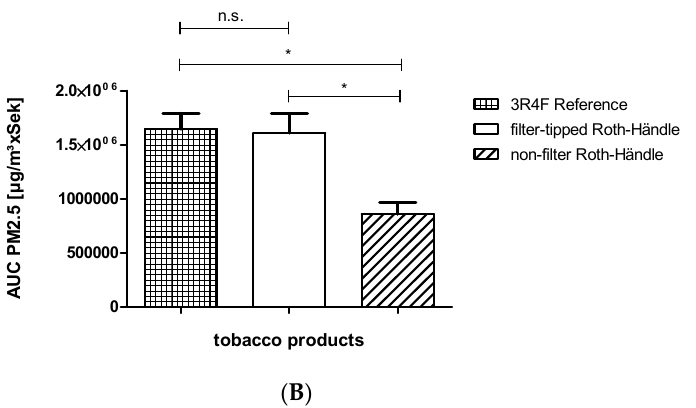
Figure 6. Comparison of the 3R4F, filter-tipped Roth-Händle and non-filter Roth-Händle. Significance was assumed when p < 0.05 (* means significant). ( A ) PM 2.5 mean concentrations and ( B ) PM 2.5 AUC are compared.